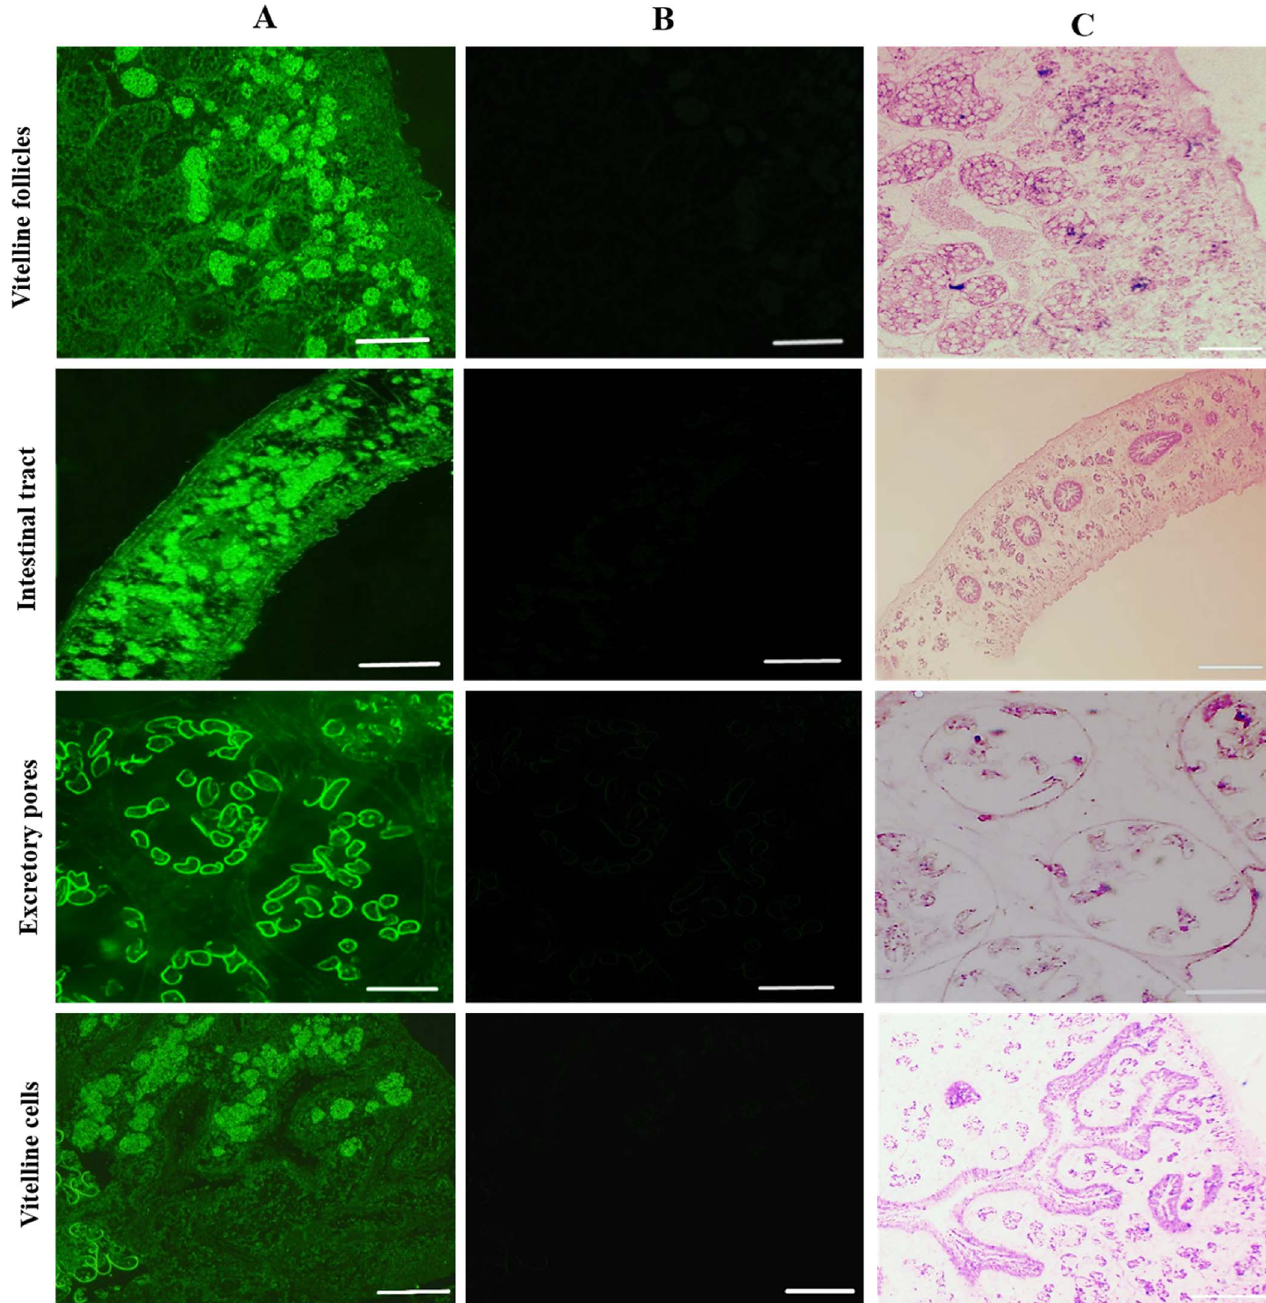
Figure 2. Immuno fl uorescence localization assay of GSTO2 protein expressed in F. hepatica. (A) Adult sections were incubated with mouse anti-rGSTO2 IgG (1:200) and subsequently incubated with FITC-conjugated goat anti-mouse IgG (1:1500 dilutions). (B) The same sections as column (A) were incubated with naïve mouse serum (1:200, negative control) and then incubated with FITC-conjugated goat anti-mouse IgG (1:1500 dilutions). (C) HE staining of sections of adult F. hepatica , scale-bars: 50 l m